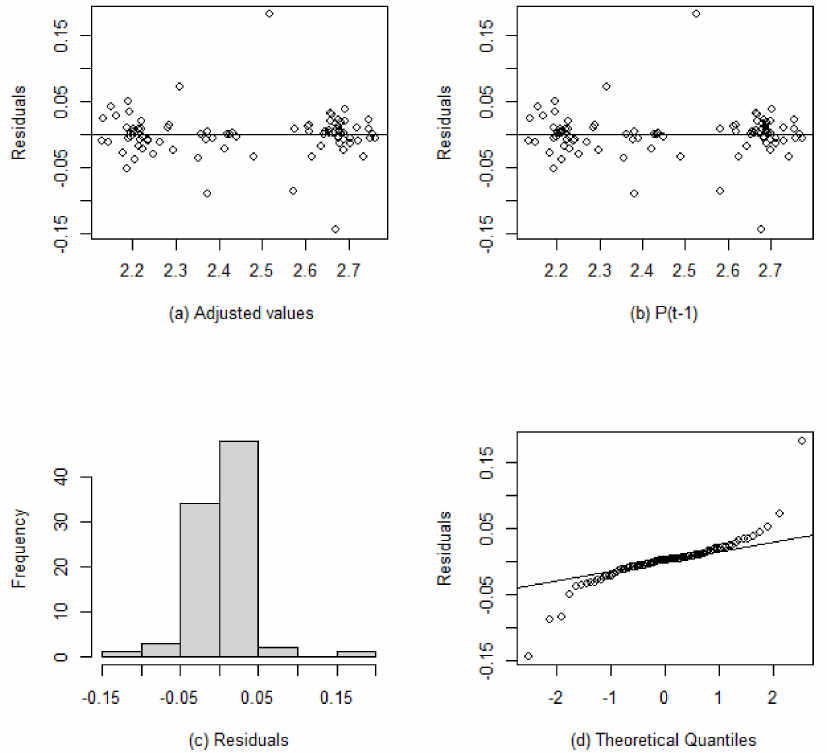
Figure 1. Analysis of regression residuals, with ( a ) diagram for a residual dispersion and adjusted values; ( b ) scatter plot of the residuals against the predicted values; ( c ) residual histogram; ( d ) dot plot of sample quantiles against theoretical quantiles from the standard normal distribution. Then, through the KPSS test, we found that our time series has a true long memory ( p -value of 0.1). Therefore, using the Geweke and Potter-Hudak (GPH) estimate for our time series of the price of Eucalyptus wood ( lnP ) , we obtained the value 0.93 of true long memory or fractional difference ( d ). This resulted in the Hurst coefficient to 0.43 for the differentiated series ( lnP t − lnP t − 1 ) in demonstrating the historical series behavior of the Eucalyptus wood price when modeled through stochastic models. Figure 2 was plotted, representing the evolution of Eucalyptus wood prices following the fractional Brownian motion and the evolution through the geometric Brownian motion. The dashed line represents the slightly negative trend in